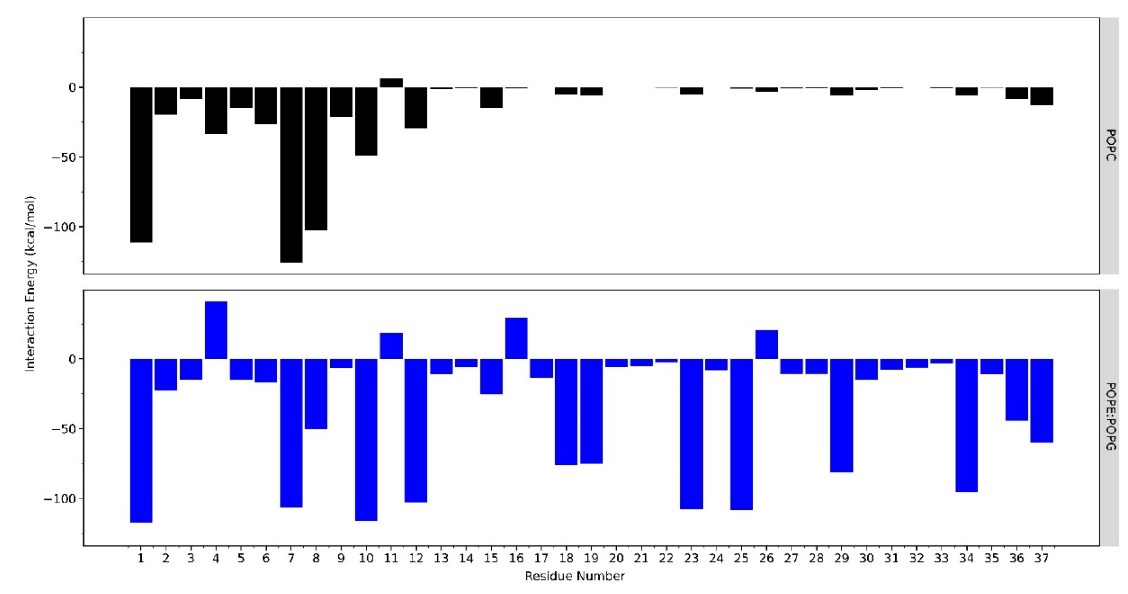
Figure 4. The average interaction energy of each residue of LL-37 during the 600 ns simulation with the POPC and POPE:POPG membrane systems. The data were calculated using the NAMD energy from VMD.